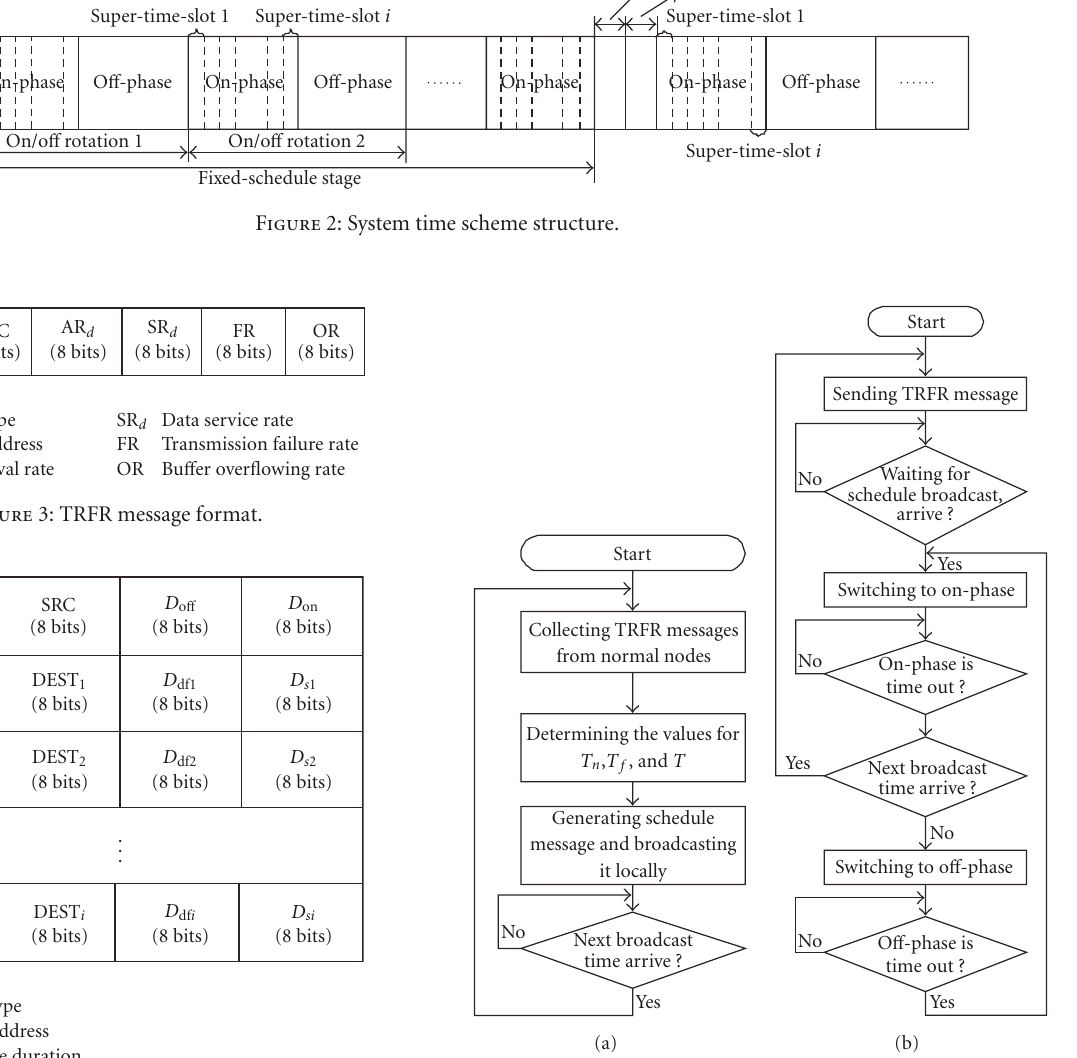
Figure 5: Flow chart for (a) data-gathering nodes and (b) data- collection nodes to establish and maintain matching schedules in